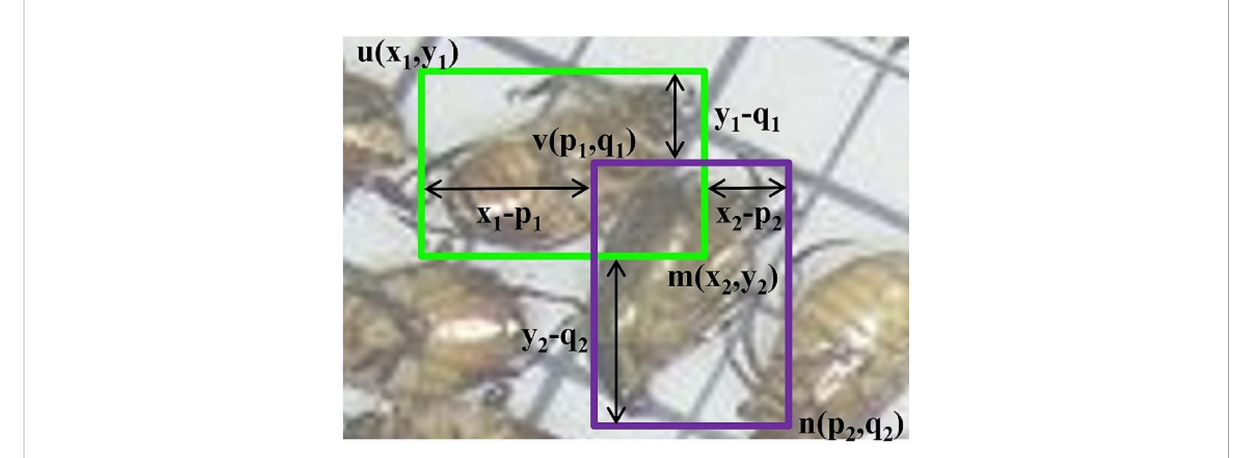
FIGURE 4 Adjacent block diagram detection; ( x, y ) and ( p, q ) are the coordinates of the bounding boxes ’